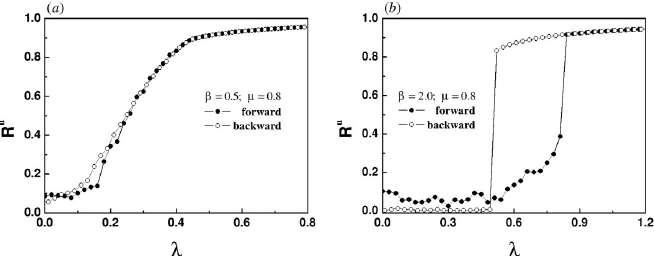
Fig 7. The evolution of order parameter of the upper layer with the increase of inter-layer coupling strength for different values of β , (a) β = 0.5, (b) β = 2.0. The intra-layer coupling strength μ is set to 0.8. Every data point in the two panels is the average of 2000 time steps after discarding the initial 2000 time